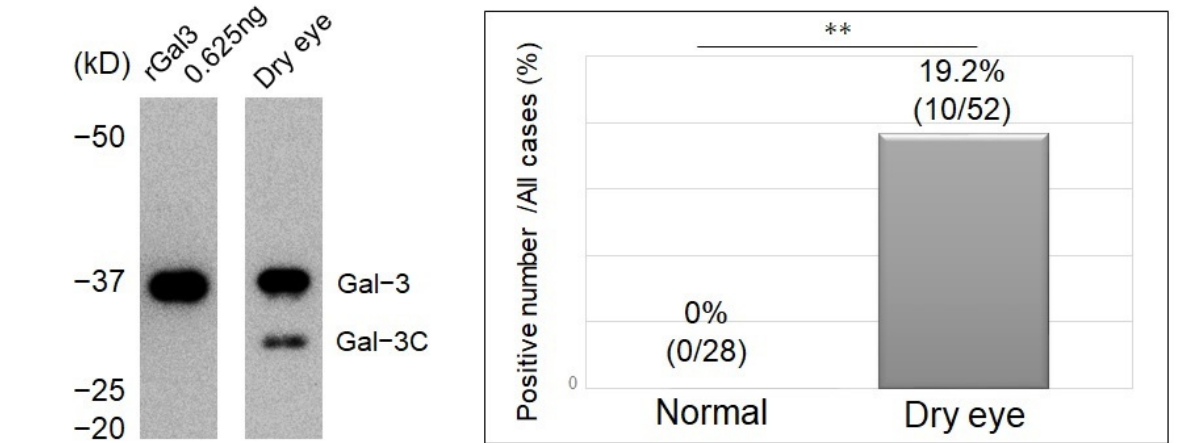
Figure 4. The detection rate of gal-3C in patients and controls. Gal-3C was detected in 19.2% of patients with dry eye disease, and not detected in controls ( p < 0.01) ** p < 0.01; gal-3C, cleaved galectin-3.